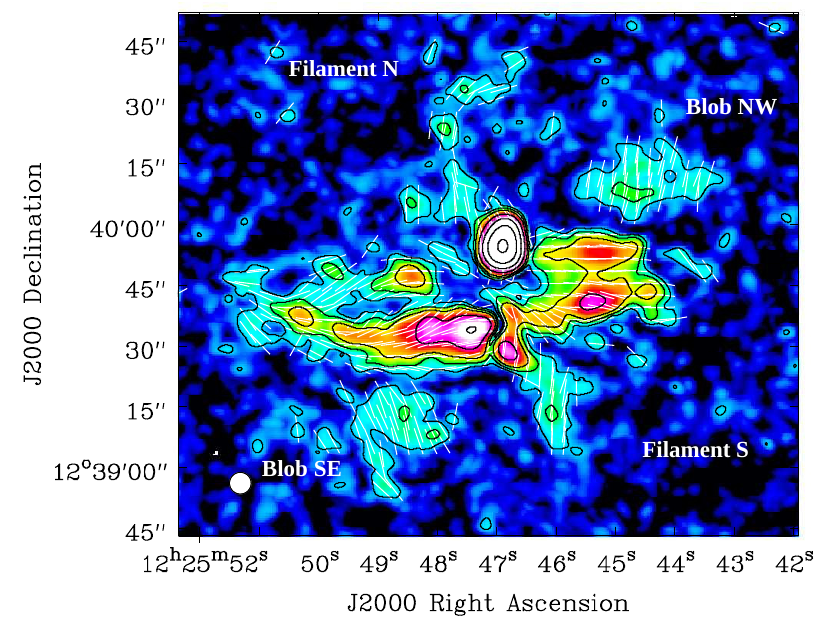
Figure 7. Linearly polarized intensity at 6 GHz in contours plus magnetic vectors corrected for Faraday rotation, with a resolution of 5.33 5.33 arcsec and an rms noise of 2.3 µ Jy beam − 1 . The contour levels × are (3, 5, 8, 16, 32, 64, 128) 2.3 mJy beam − 1 . The beam is shown as a white dot at the lower left. ×